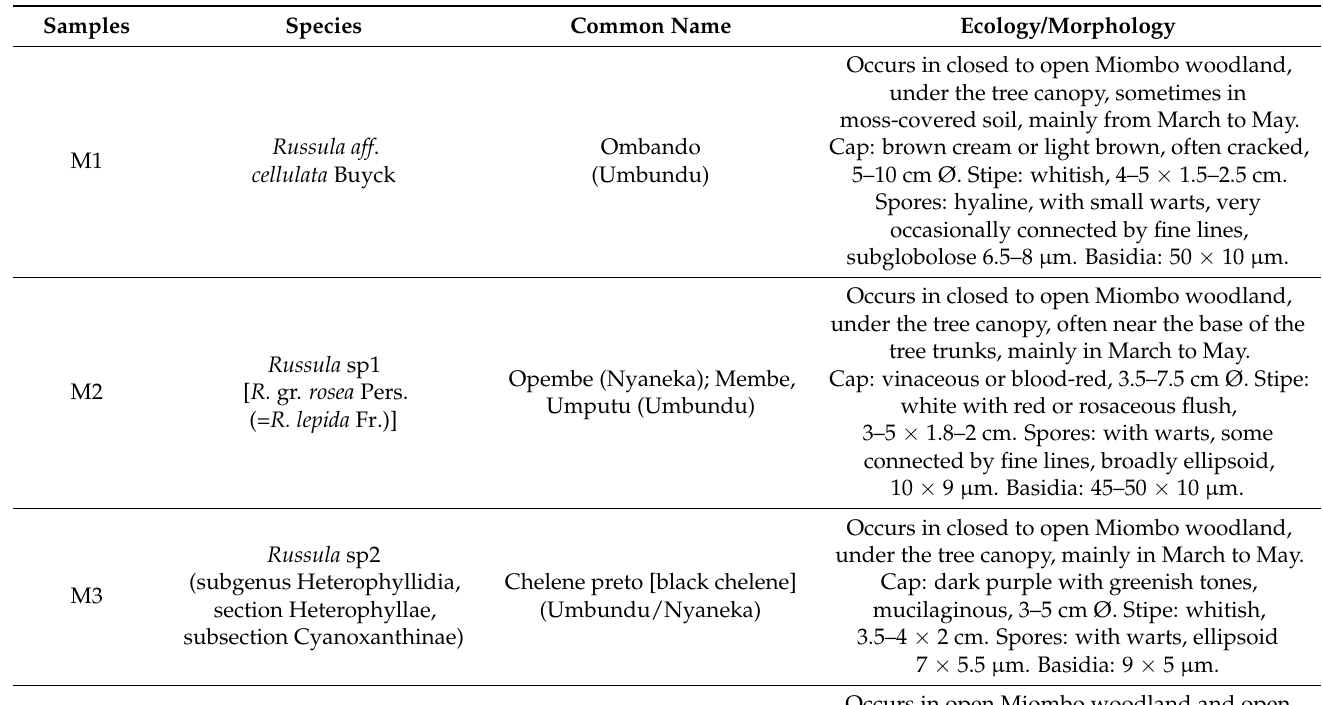
Table 1. Characterization of the eight morphotypes found in the dried mushrooms sample from Humpata market, Angola (Note: cap and stipe dimensions were taken on dried